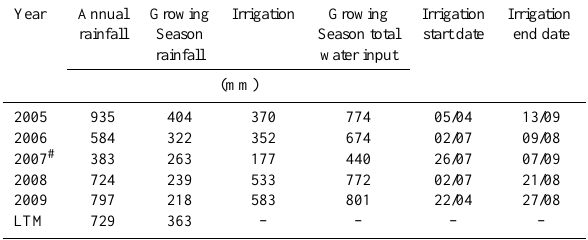
Table 1. Amounts and timing of water additions to the wet treat- ment by irrigation, and total water input (i.e., irrigation + rainfall) for the growing season (March to September), for the five years of the water manipulation experiment. For comparison, annual rain- fall, rainfall during the growing season and long term means (LTM, 1980–2010) are also